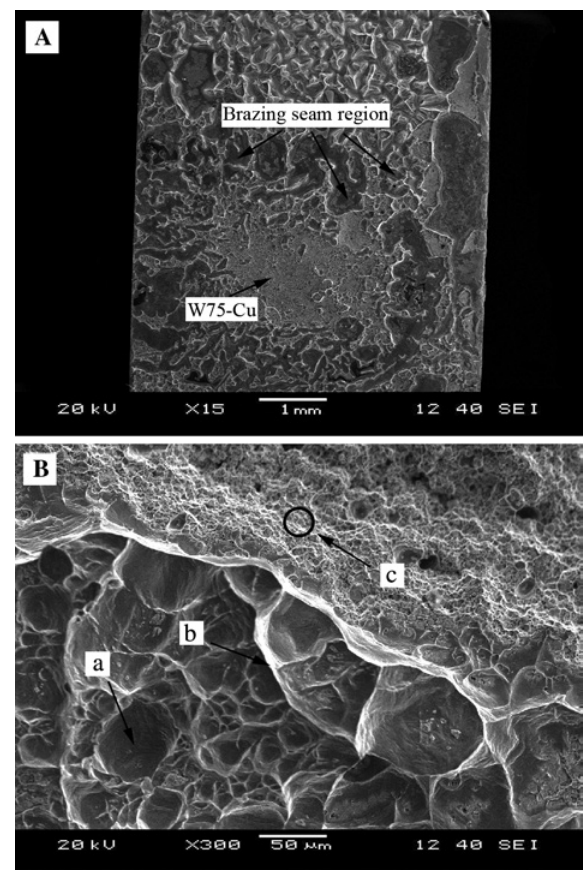
Figure 7: Sketch of the four-point bending test.